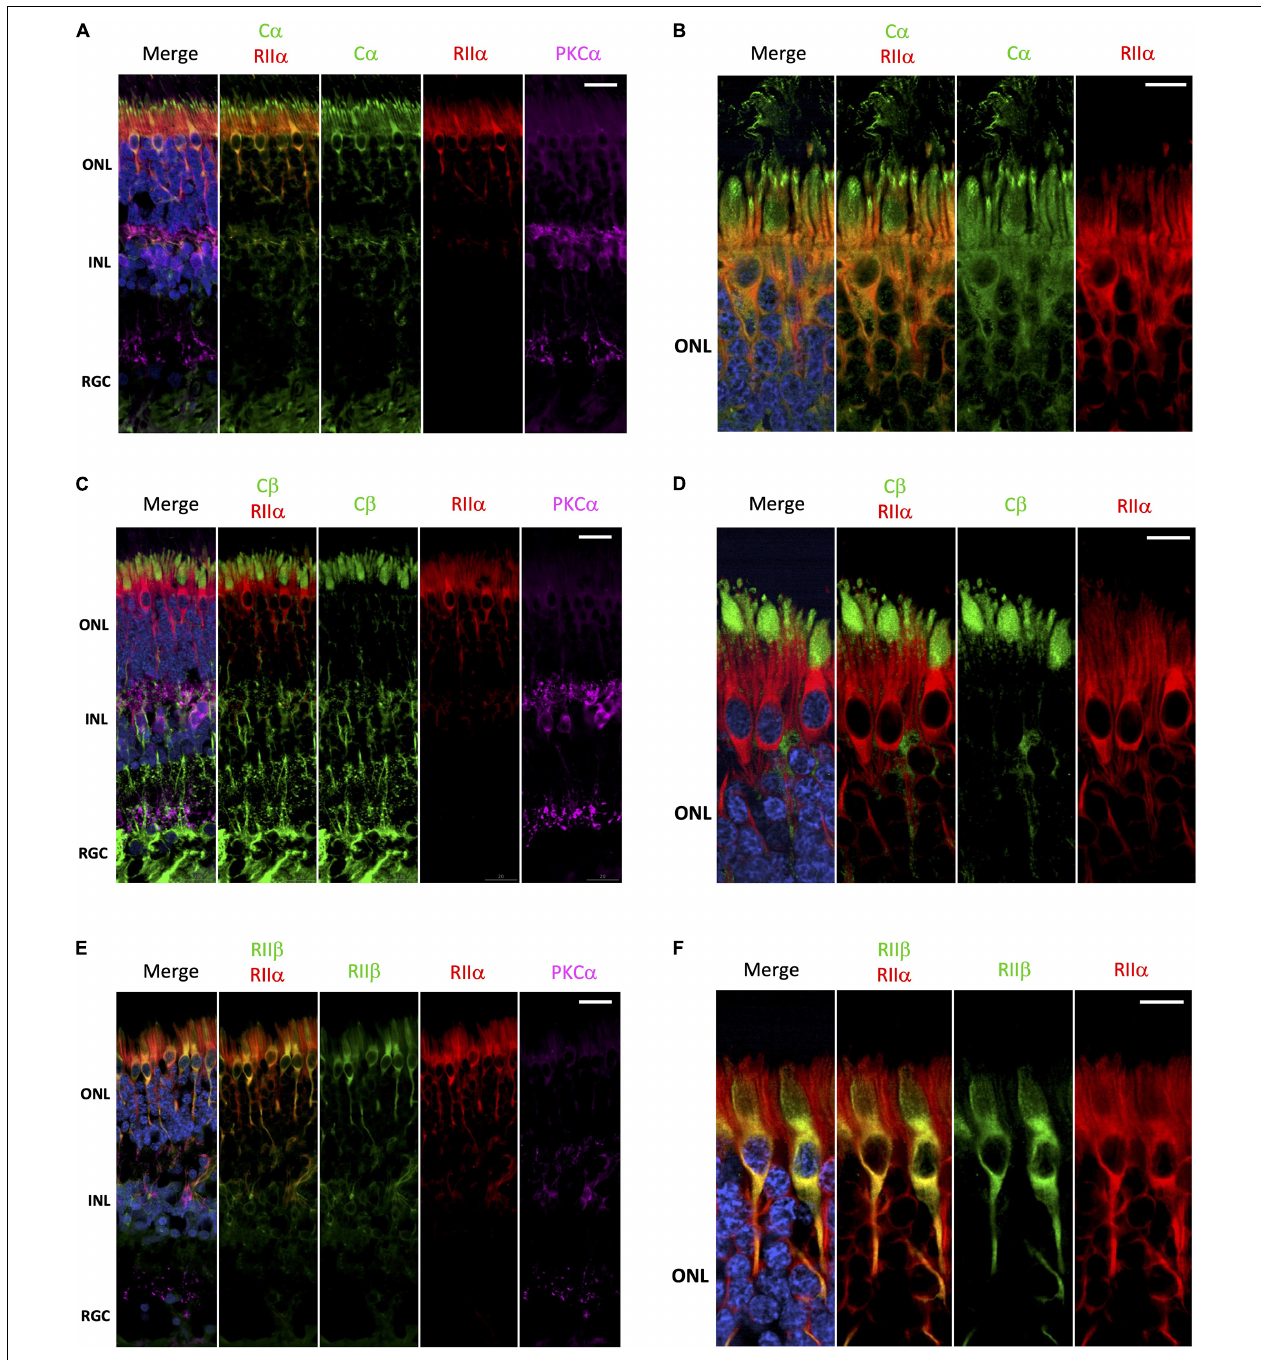
FIGURE 4 | C α , but not C β , co-localizes with RII α ; RII α and RII β show similar localization. (A–F) All sections were labeled with anti-PKC α antibodies in order to identify rod-bipolar cells (purple), which helped distinguish between the outer nuclear layer (ONL), inner nuclear layer (INL), and retinal ganglion cell layer (RGC). Nuclei in blue, scale bar = 20 µ m (A,C,E) , 10 µ m (B,D,F) . (A) C α (green) and RII α (red) co-localized in photoreceptors and interneurons in the ONL and INL (orange, C α RII α ). Only C α was localized to the RGC. (B) In photoreceptors, C α (green) and RII α (red) clearly co-localized in the cell body and axons (orange, C α RII α ); however, only C α was present in the outer segment membrane and at the junction connecting the inner and outer segment. (C) C β (green) and RII α (red) intracellular localization differs in cells in the ONL and INL, with no signal overlap (C β RII α ) in photoreceptors or interneurons. Only C β was localized to the RGC. (D) C β (green) and RII α (red) both clearly localized to photoreceptors; but C β is found in the inner segment, while RII α is found in the cell body and axons, with no signal overlap (C β RII α ). (E) RII β (green) and RII α (red) co-localized in cells in the ONL and INL, with strong signal overlap (orange, RII β RII α ) in photoreceptors and interneurons. Neither RII β and RII α were localized to the RGC. (F) In photoreceptors, RII β (green) and RII α (red) clearly co-localized to the cell body and axons (orange, RII β RII α ); however, RII β was distinctly enriched in cone photoreceptor cells, while RII α was diffusely distributed in both rod and cone photoreceptor cells.